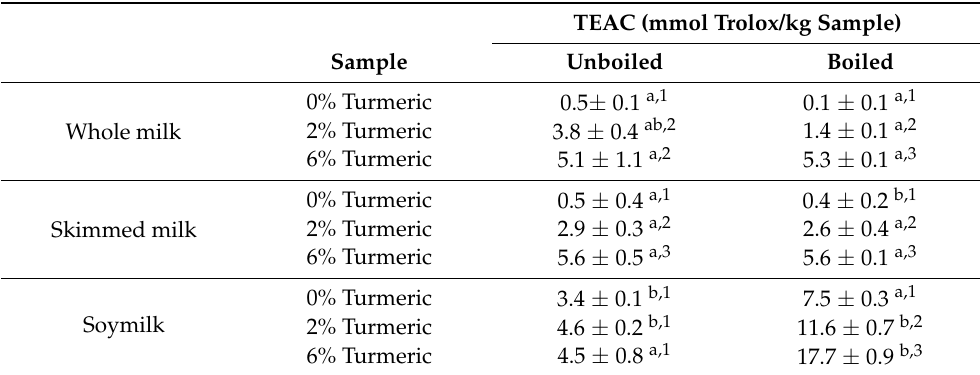
Table 2. Antioxidant activities of turmeric-fortified whole milk, skimmed milk, and soya milk before and after heat treatment expressed in Trolox equivalent antioxidant capacity